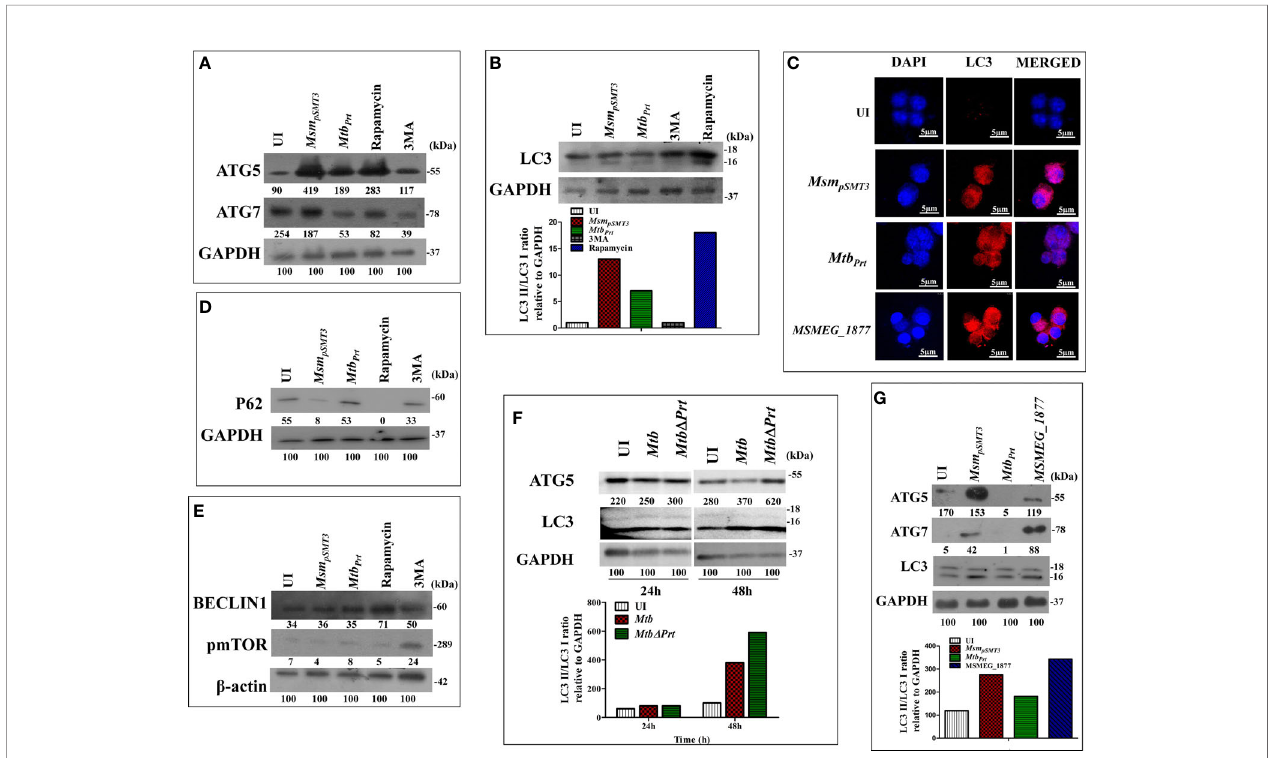
FIGURE 1 | Expression of Autophagy related genes in Msm pSMT3 , Mtb Prt , Mtb H37Rv, Mtb D Prt and MSMEG_1877 infected macrophages. RAW264.7 cells were infected with Msm pSMT3 and Mtb Prt for 24 h. The level of (A) ATG5 and ATG7 expression at protein level was checked by western blotting. The conversion of LC3I to II was estimated using (B) western blotting (Densitometry is representative to the particular western blot data) and (C) confocal microscopy using LC3I/II speci fi c antibodies. The level of (D) P62 , (E) Beclin1 and phospho- mTOR expression at protein level was checked by western blotting in RAW264.7 infected with Msm pSMT3 and Mtb Prt . (F) The level of ATG5 and conversion of LC3-I to II was checked in Mtb H37Rv and Mtb D Prt infected RAW264.7 cells by western blotting after 48 h of infection. (G) The conversion of LC3I to II, ATG5 and ATG7 expression in RAW264.7 infected with Msm pSMT3 , Mtb Prt and MSMEG_1877 was checked by western blotting. The experiments were performed in triplicate (n=3). Msm pSMT3- Msm harbouring pSMT3 plasmid; Mtb Prt - recombinant Msm expressing MtbPrt (Rv3242c) ; Mtb D Prt – Mtb Prt deletion mutant in Mtb